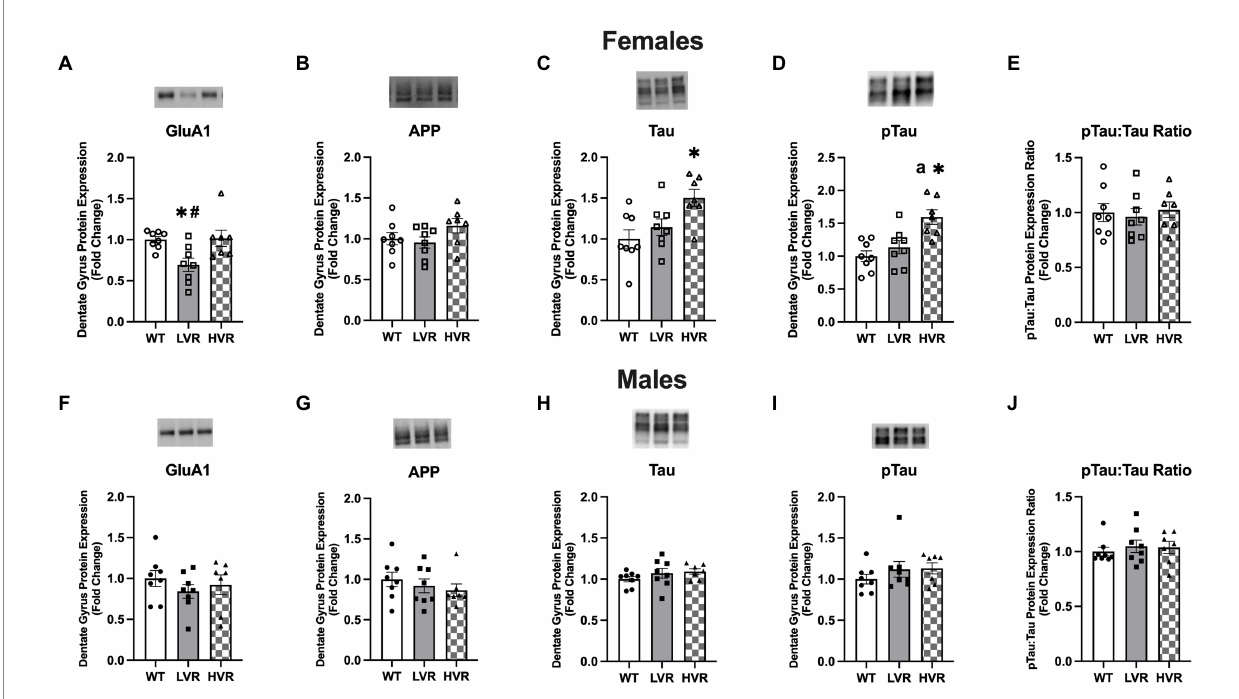
FIGURE 4 Female LVR have reductions in dentate gyrus GluA1 protein expression. (A–E) Protein expression levels of GluA1, APP, Tau, pTau, and pTau:Tau Ratio in female WT ( N = 8), LVR ( N = 8) and HVR ( N = 7). (F–J) Protein expression levels of GluA1, APP, Tau, pTau, and pTau:Tau Ratio in male WT ( N = 8), LVR ( N = 8) and HVR ( N = 7). a The significant difference between LVR and HVR. * Denotes significant Tukey post-hoc difference relative to WT following one-way ANOVA. # Denotes significant Tukey post-hoc difference relative to HVR following one-way ANOVA. Values expressed as mean + SEM.